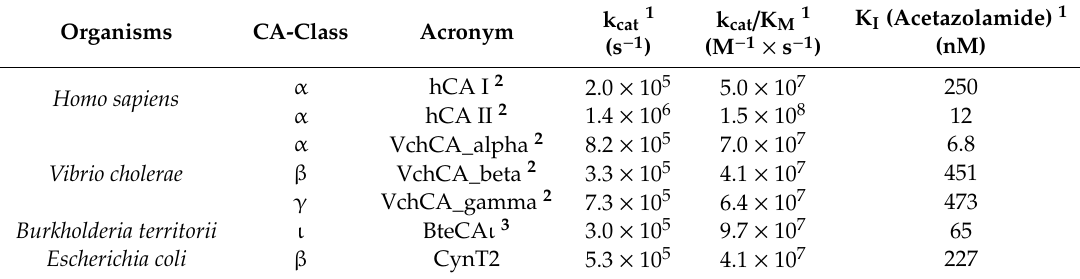
Table 2. CynT2 kinetic parameters for the CO 2 hydration reaction. The CynT2 calculated kinetic constants were compared with those determined for the two human isoforms hCA I and II ( α -class), the α -, β -, γ -CAs from Vibrio cholerae and ι -CAs from Burkholderia territorii . The reaction was performed at 25 ◦ C, in 20 mM Tris bu ff er and 20 mM NaClO 4 , pH 8.3. Inhibition data with the clinically used acetazolamide are also